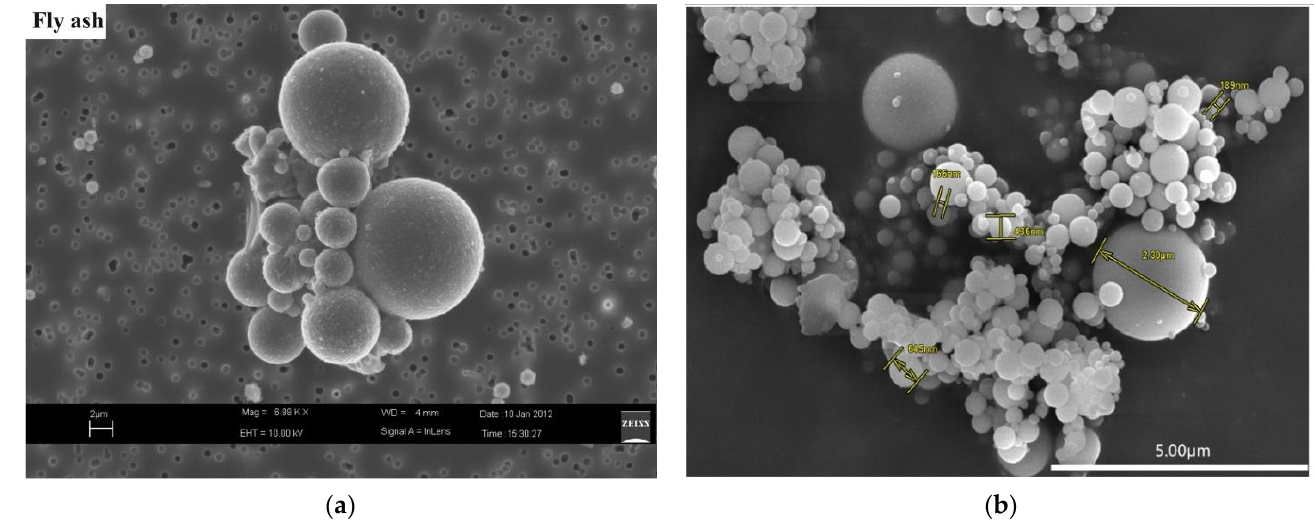
Figure 1. Micrograph of fly ash: ( a ) [70]; ( b ) [71] .